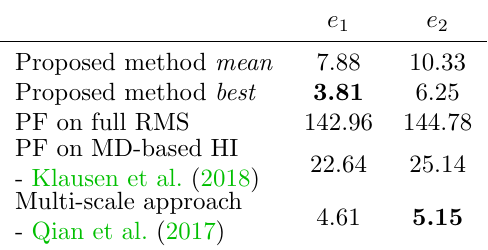
Table 3: Comparison of error. The best values are shown in bold.